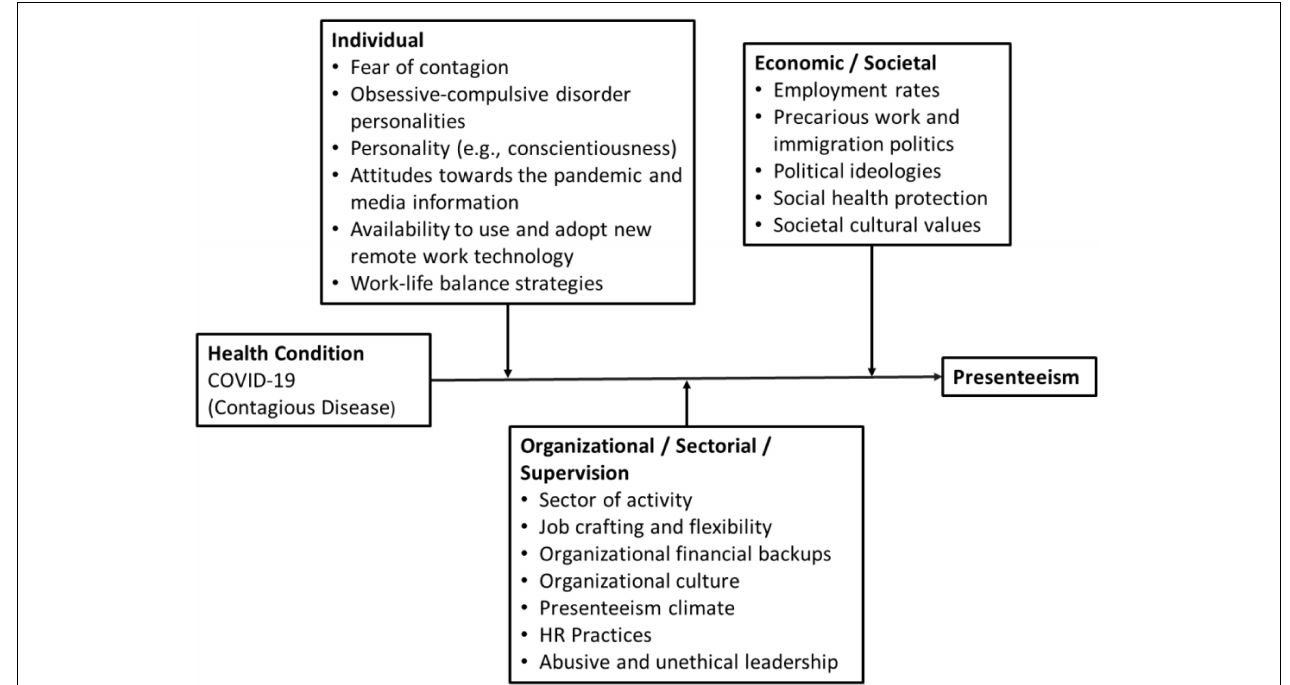
FIGURE 1 | A conceptual model of presenteeism in pandemic